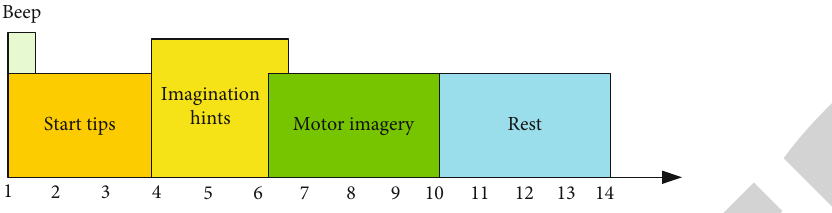
Figure 10: Time paradigm of data acquisition experiment.